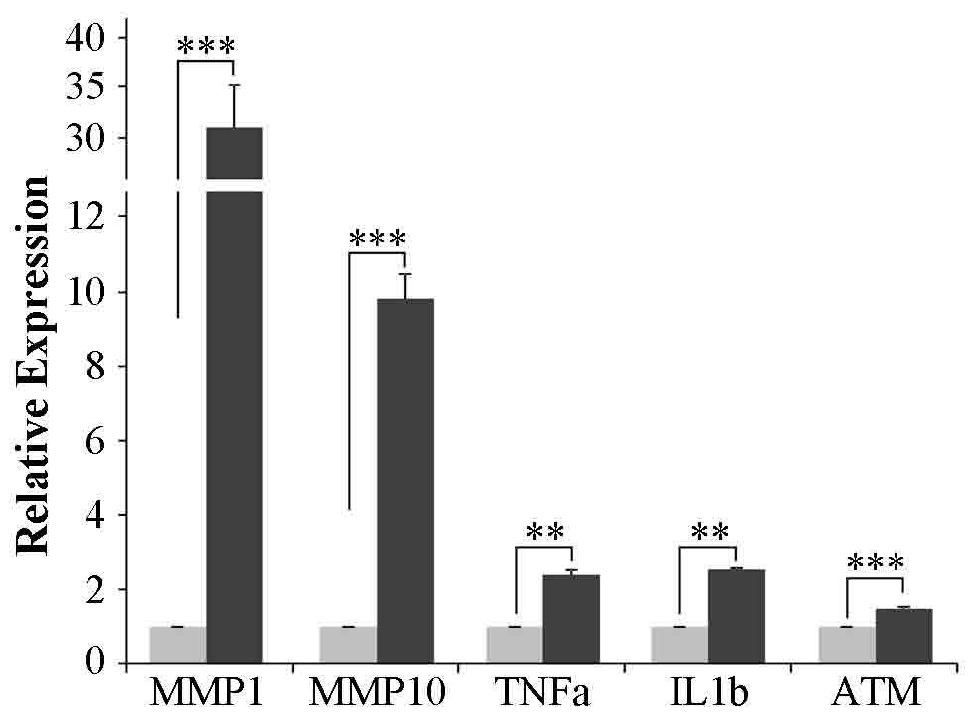
Figure 7. Microarray data validation by qRT-PCR in A549 cells treated with SM30 NPs. Values (fold change) are means ± S.D. of independent experiments performed in